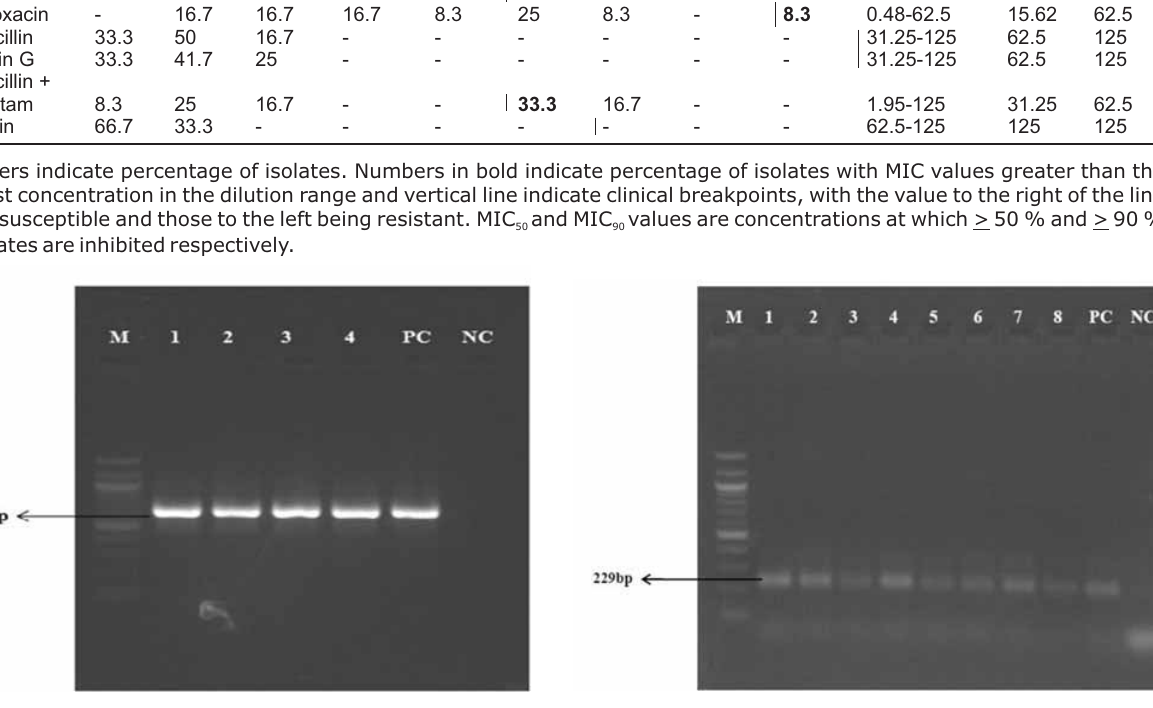
E. coli. S. aureus. Figure-2: Amplification of 16s-23s rRNA gene of Figure-3: Amplification of 16s-23s rRNA gene of E. coli S. M: 100bp ladder, 1-4: test samples, PC: Positive M: 100bp ladder, 1-8: test samples, PC: Positive control, NC: Negative control. control, NC: Negative control.